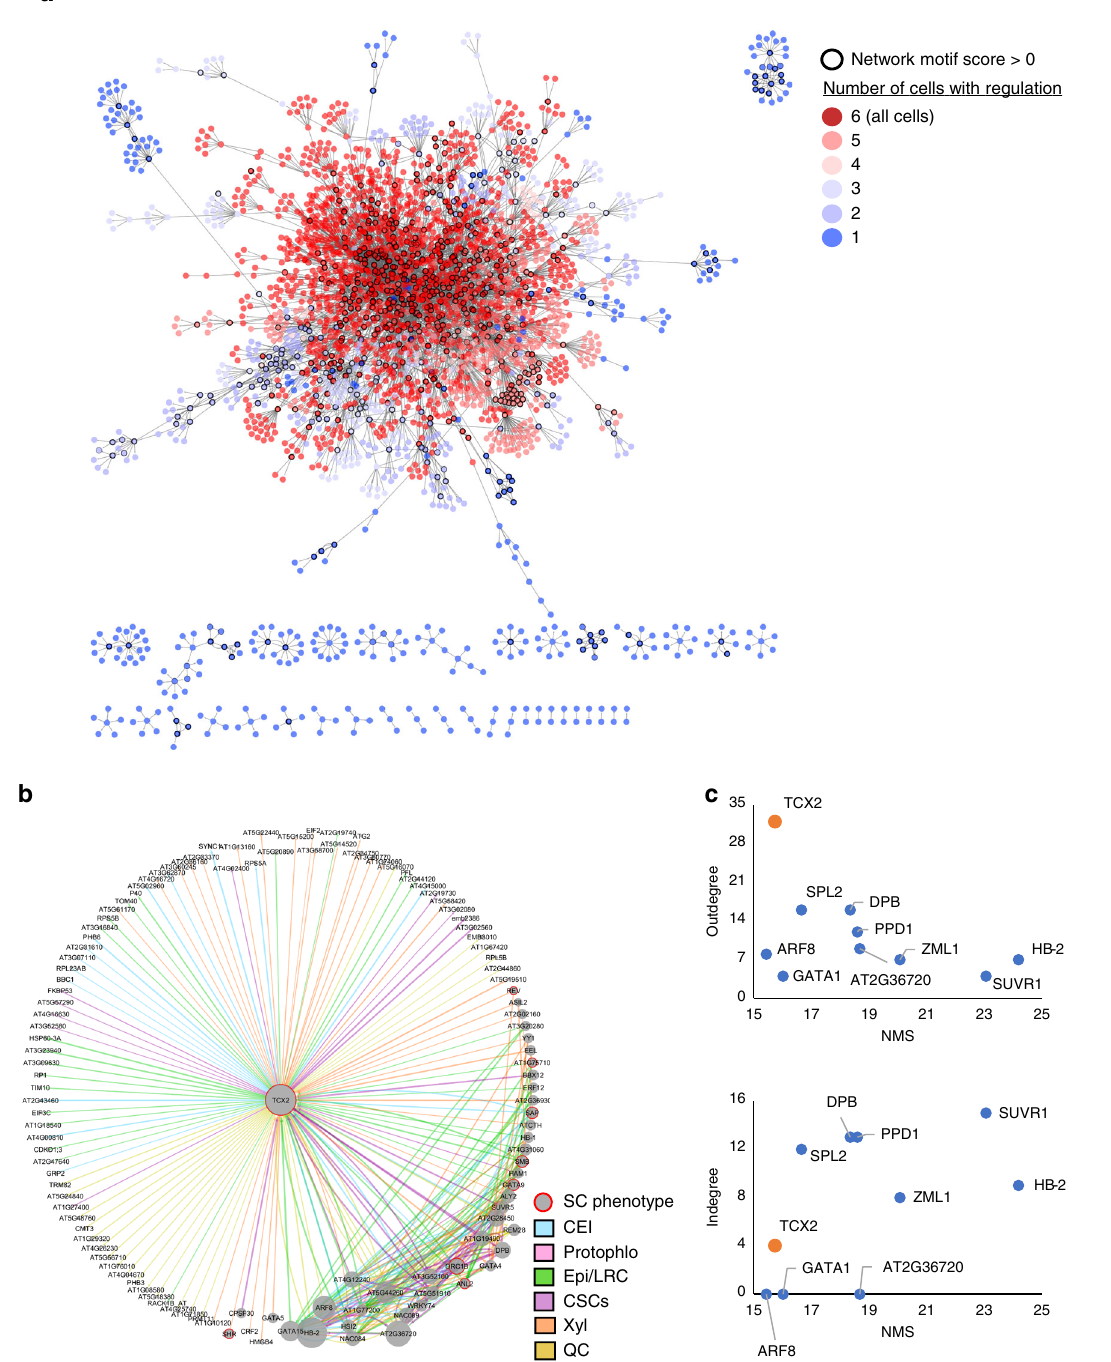
Fig. 2 Gene regulatory network (GRN) of the stem cell-enriched genes. a Inferred GRN of 2982 out of the 9266 stem cell-enriched genes. Genes are colored based on the number of genes in which they are enriched, with red genes (>3 enriched cells) considered stem-cell-ubiquitous and blue genes ( ≤ 3 enriched cells) considered stem-cell-speci fi c. Black outlines represent hub genes which have a network motif score (NMS) > 0. b First-neighbor GRN of TCX2. Gene size represents the NMS score. Red borders represent the genes which have a known stem cell (SC) phenotype. Edge colors represent the cell in which the regulation is inferred. Blue — CEI; Pink — Protophlo; Green — Epi/LRC; Purple — CSCs; Orange — Xyl; Yellow — QC. c Outdegree (top plot) and indegree (bottom plot) vs NMS score of the genes with the top 10 NMS scores in a . TCX2 is highlighted in